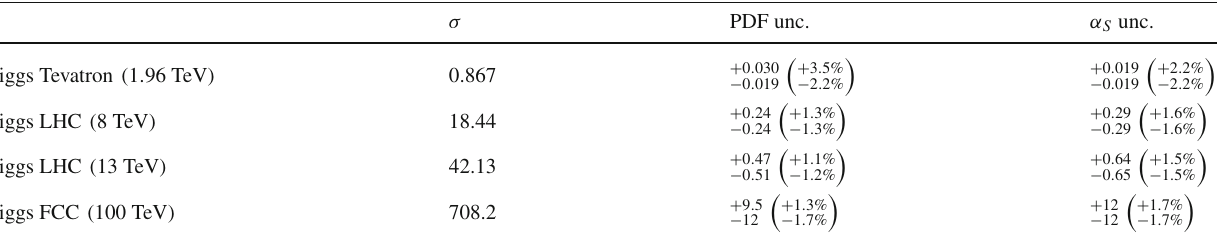
Table4 PredictionsfortheHiggsbosoncrosssections(inpb),obtained withtheNNLOMSHT20partonsets.ThePDFand α S uncertaintiesare shown, where the α S uncertainty corresponds to a variation of ± 0 . 001